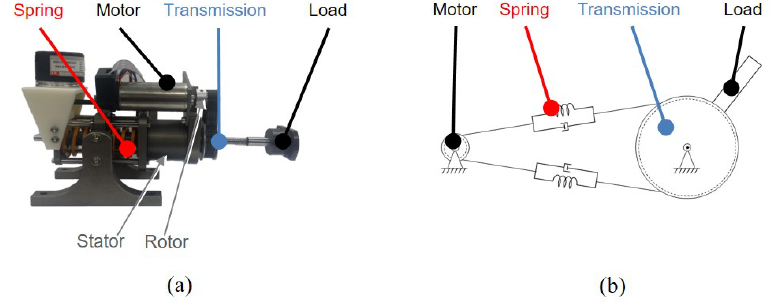
Figure 7. Example models of RFSEA. ( a ) University of Texas-Series Elastic Actuator (UT-SEA) and ( b ) Series Elastic Actuator of